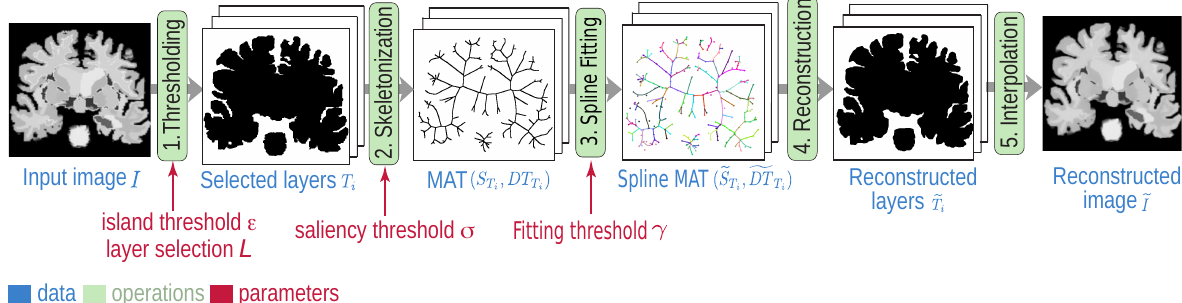
Figure 1. Spline-based Dense Medial Descriptors (SDMD) pipeline with free (user controlled) parameters in